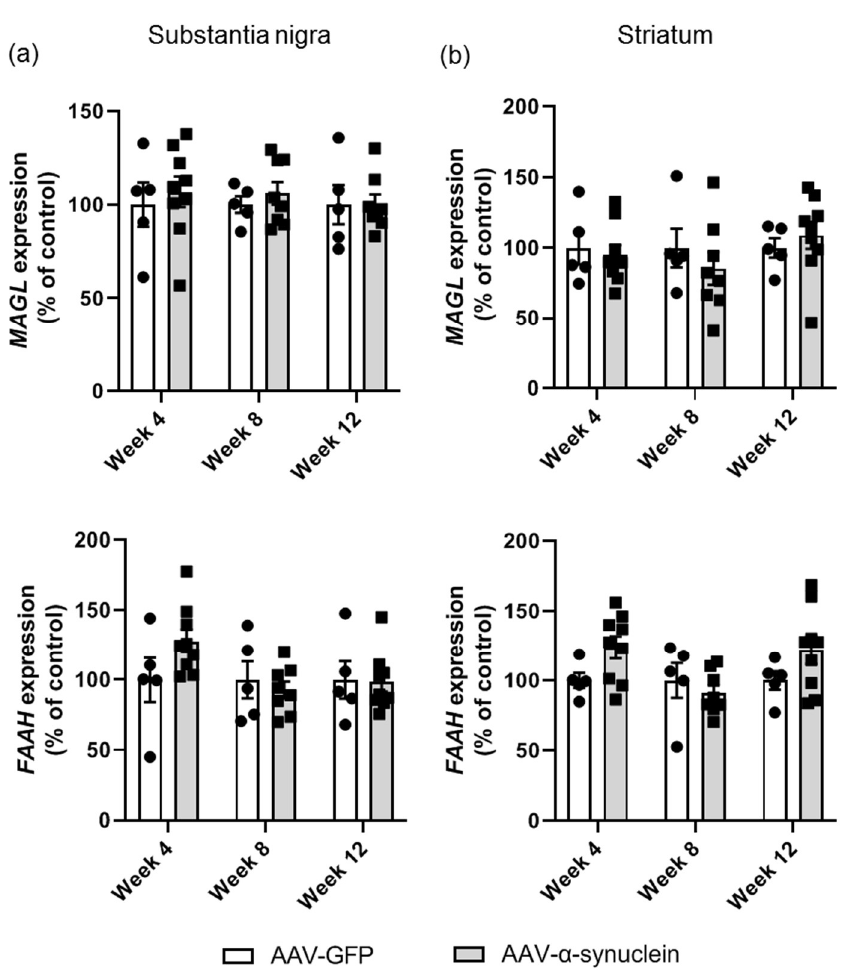
Figure 6. qRT-PCR analyses of the expression of endocannabinoid degrading enzymes in the nigrostriatal pathway. Administration of AAV- α -synuclein did not induce alterations in the expression of MAGL or FAAH in ( a ) the substantia nigra or ( b ) the striatum. Data are represented as mean ± SEM with 5–9 animals per group by two-way ANOVA.